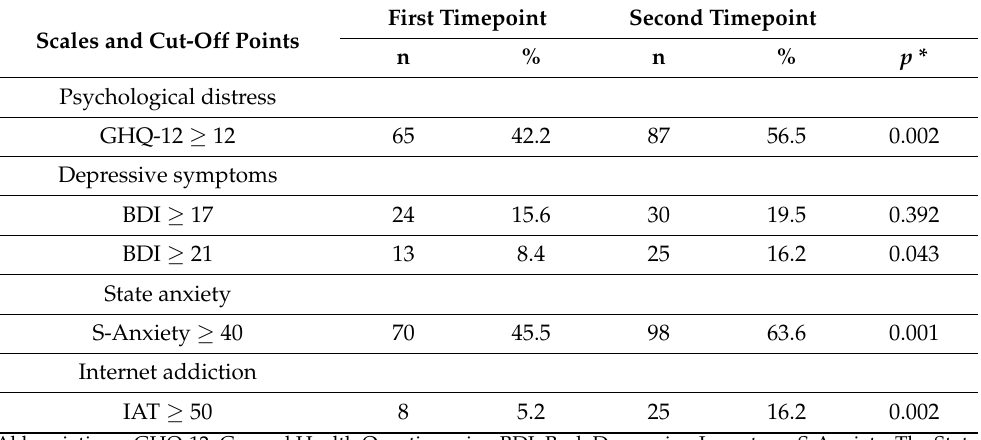
Table 3. Psychological morbidity prevalence of nursing students in the first and second timepoints ( n = 154).